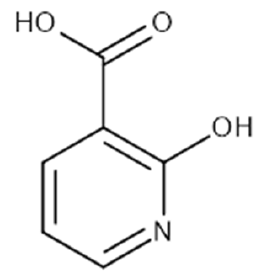
Figure 4. Chemical structure of 2-hydroxynicotinic acid. 2-Hydroxynicotinic acid is the chemical analog of nicotinic acid containing an additional hydroxyl group on carbon 2. Table 2. Selected structurally diverse compounds and 2-HNA analogs for in vitro characterization as putative NAPRT inhibitors.